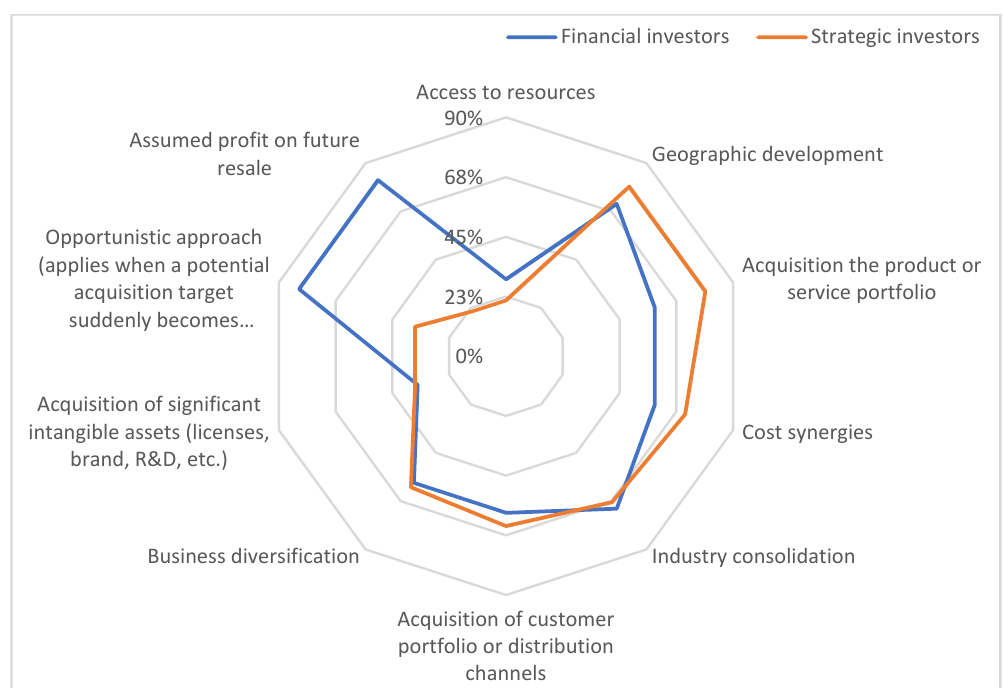
Table 7. Distance between investment motives in mergers and acquisitions undertaken by financial and strategic investors .